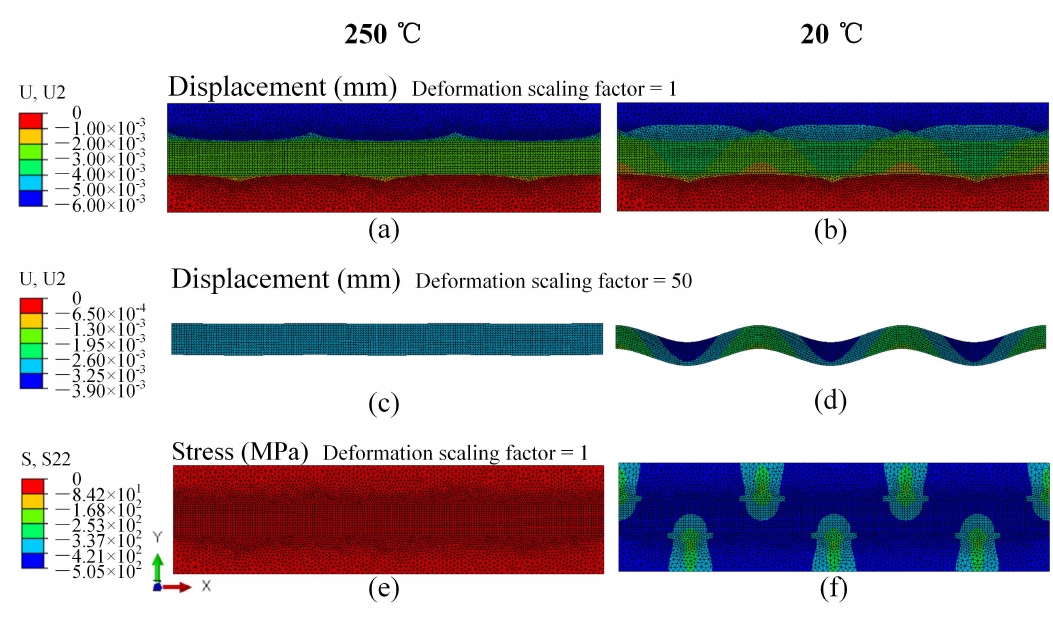
Figure A2. Simulated displacement and stress in the y-direction in the cooling phase. Displacement of the representative model at ( a ) 250 ◦ C and ( b ) 20 ◦ C; displacement of the pigtail at ( c ) 250 ◦ C and ( d ) 20 ◦ C; stress of the representative model at ( e ) 250 ◦ C and ( f ) 20 ◦